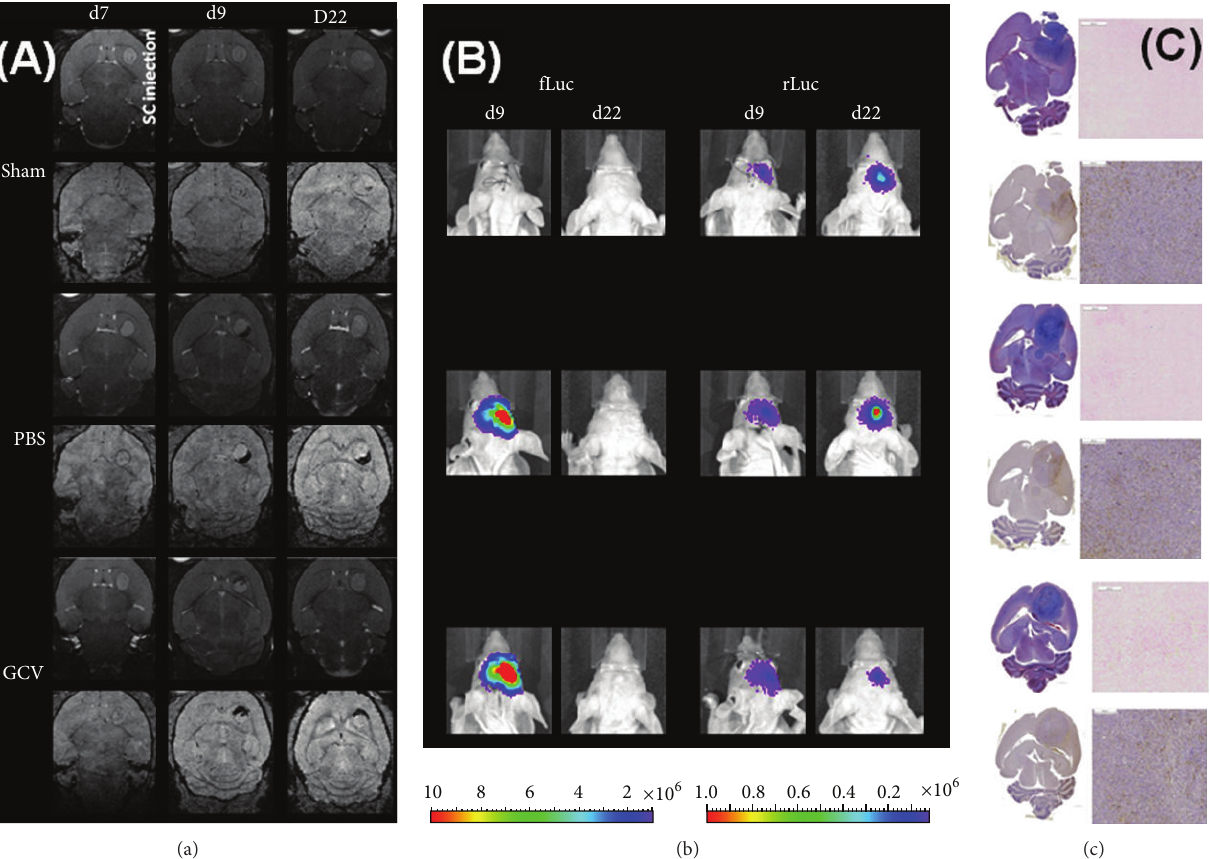
Figure 8: Follow-up of suicide gene therapy using hMultistem as cellular vehicles in the hU87 glioma model by using multimodal in vivo imaging and histology. (a) MR images of a representative animal from the sham, PBS, and GCV treated groups show a comparable tumor growth prior to hMultistem injection on T 2 -weighted MR images (upper row for each group). While there is little hypointense contrast visible on 3D T ∗ 2 -weighted MR images (lower row for each group), the distribution of SPIO labeled hMultistem cells could clearly be detected due to their hypointense contrast in the PBS and GCV treated group (one day after engraftment). The contrast distribution changed only very little until the end of treatment. When tumors grew larger, the hypointense voxels got more dispersed over time. (b) Left: bioluminescent imaging using D-luciferin as a substrate for fLuc expressing hMultistem cells. Stem cells were detectable after engraftment but not after the end of treatment for both, the PBS and GCV receiving groups. Right: bioluminescence imaging using coelenterazine-h as a substrate for rLuc expressing hU87 tumor cells. The signal intensity increased for the sham and PBS group but not for the GCV group, indicating some inhibition of tumor growth. (c) Two weeks after the end of therapy, animals developed symptoms after which histological analysis was performed. Masson’s trichrome staining (upper left) of all animals showed large, dense tumors. Prussian blue (upper right) staining was also performed which confirmed the presence of iron in PBS and GCV treated animals. Finally, Iba1 staining (bottom) was performed which showed a predominant absence of activated microglia in all treatment